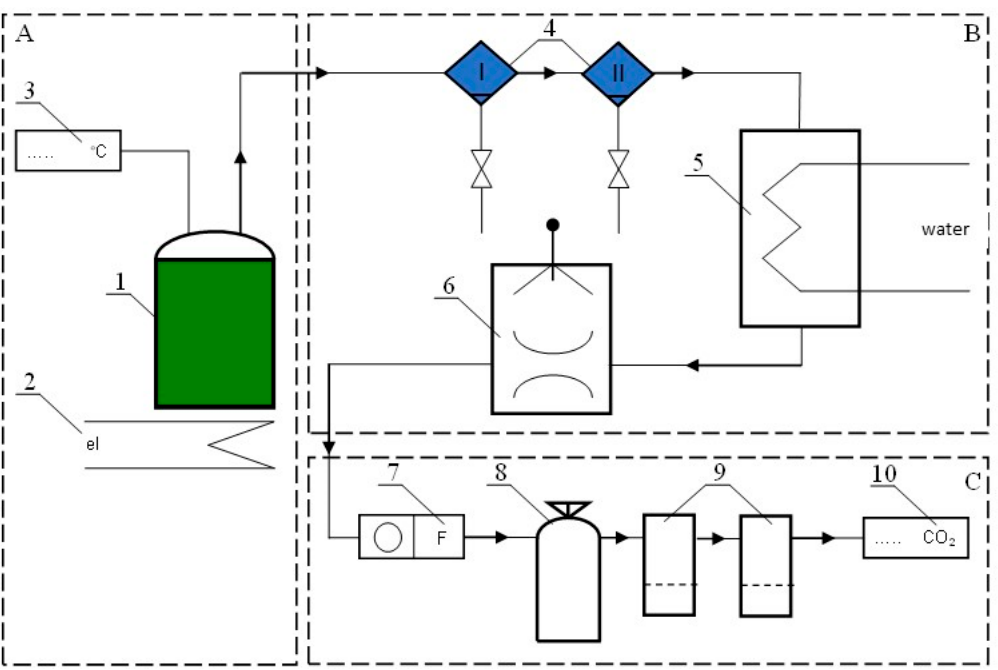
Figure 1. Scheme of the test stand [28]: ( A ) chamber of reactor system with a fixed bed, ( B ) gas cleaning and cooling system and ( C ) measurement system for gas produced; (1) gasification reactor, (2) two-stage electric heater, (3) measure the temperature inside the reactor, (4) condensation tanks with drain valves (I and II), (5) condensate tank cooled by water, (6) scrubber (absorber), (7) gas meter, (8) tank, (9) double water filter and (10) exhaust gas analyzer.